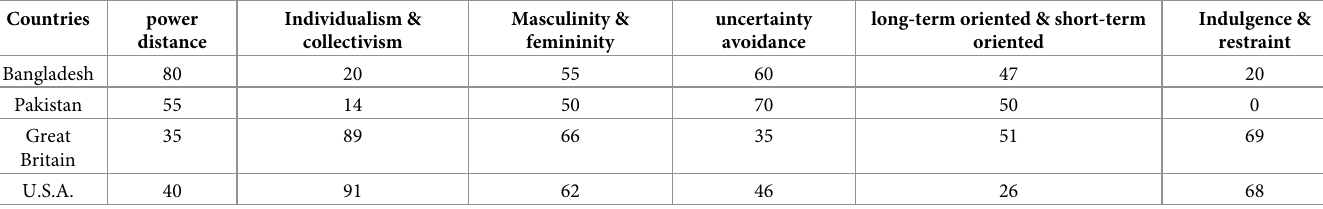
Table 13. Cultural dimension